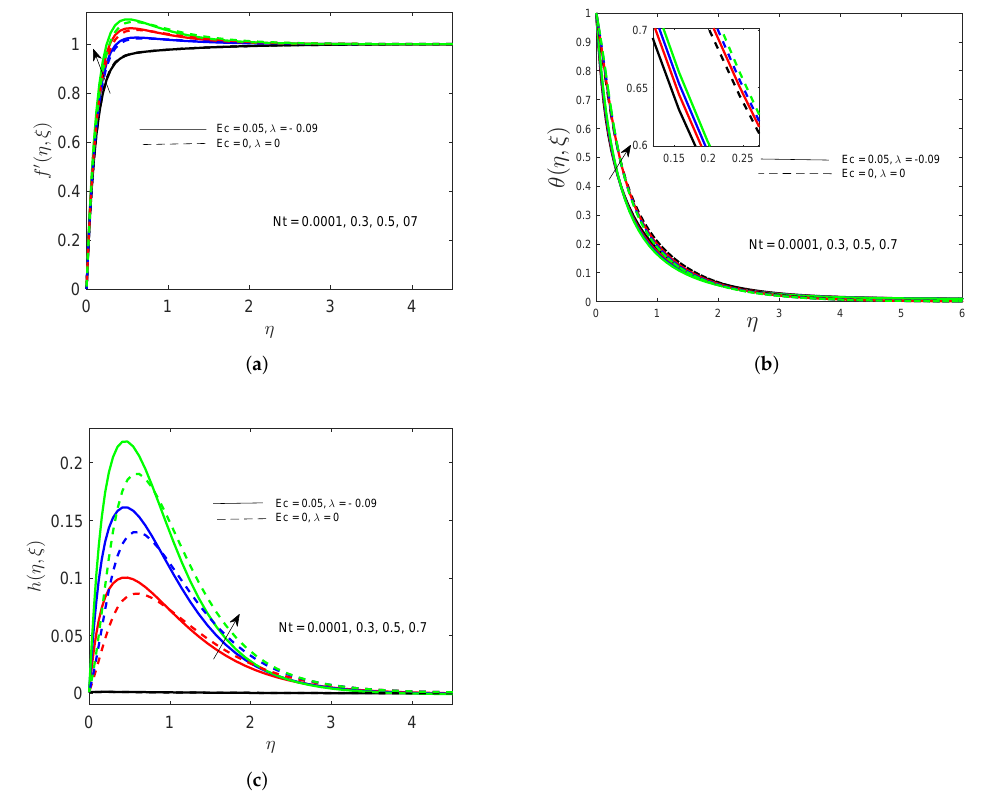
Figure 6. Impacts of the thermophoresis parameter on ( a ) velocity, ( b ) temperature, and ( c ) concen- tration